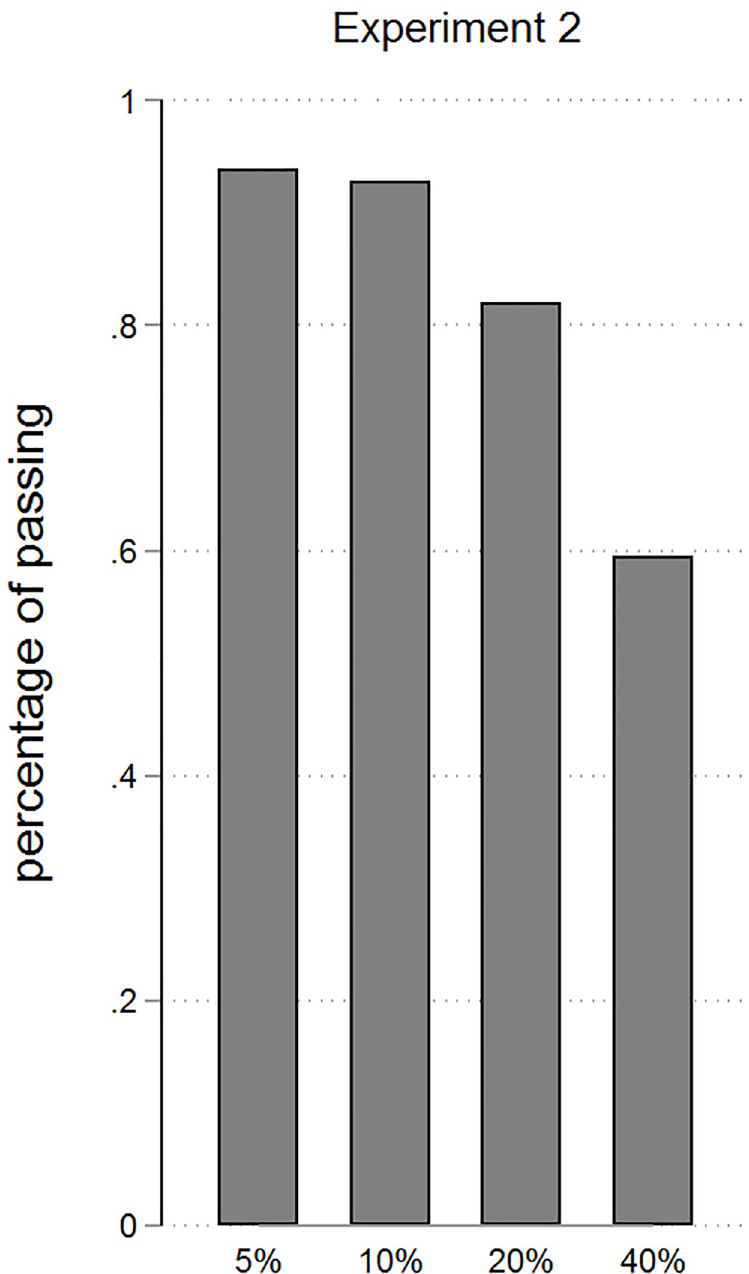
Fig 5. Percentages of passing by stages. Percentages denote the share of participants who decide to pass among all those who have reached a given stage. As can be seen in comparison with Fig 4, percentages are slightly lower than in the treatment “Soccer” but higher than those for